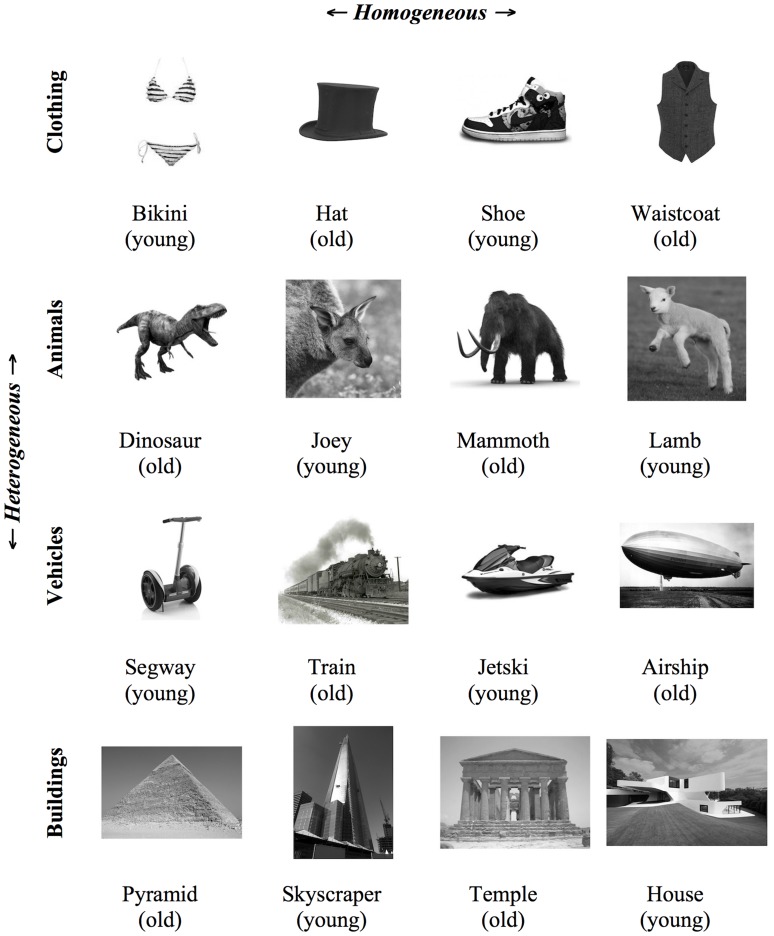
Matrix depicting the novel object stimuli employed in Experiments 2 and 3 with the blocked cyclic paradigm, consisting of sets of four categorically related (arranged in rows) and heterogeneous (columns) contexts that vary according to the relative age dimension.